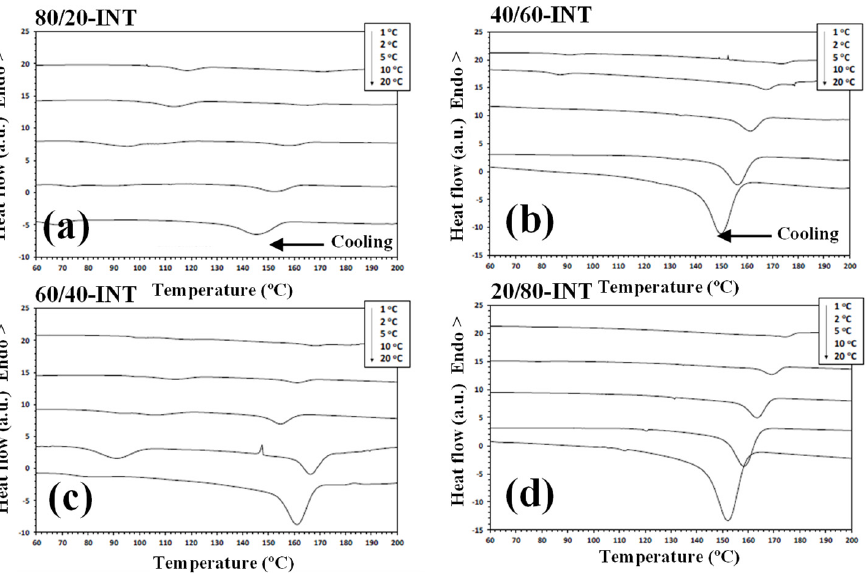
Figure 5. Non-isothermal crystallization DSC thermograms for the PLLA/nylon 11-INT blend nanocomposites at the cooling rates indicated: ( a ) PLLA/nylon 11/INT-WS 2 (80/20-INT); ( b ) PLLA/nylon 11/INT-WS 2 (60/40-INT); ( c ) PLLA/nylon 11/INT-WS 2 (40/60-INT); ( d ) PLLA/nylon 11//INT-WS 2 (20/80-INT).